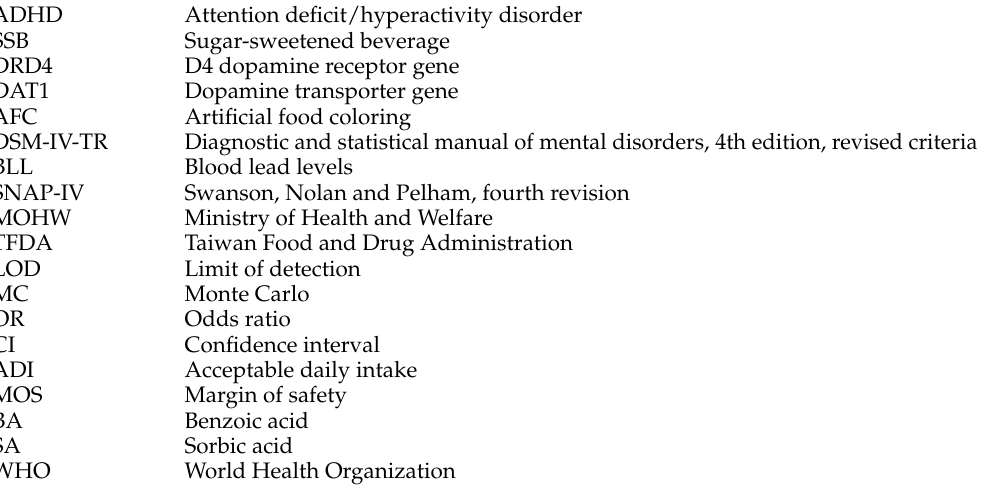
s1, Figure S1: Boxplot diagram of BLLs for ADHD and normal control participants, Table S1: Relationship between maternal education level and smoking/alcohol consumption during pregnancy, Table S2: Polymorphism of dopamine-related genes (DRD4/DAT1) of the study participants, Table S3: Frequently used artificial food